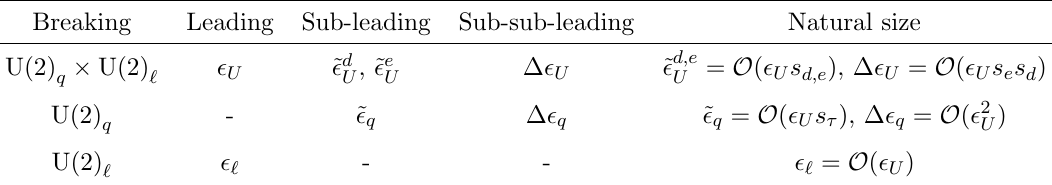
Table 2 . U(2) 5 breaking parameters arising from non-Yukawa operators. Only (cid:15) U is used as free parameter in the (cid:12)t. All the subleading terms are set to zero after checking that bounds set by present data are less stringent than the expected natural